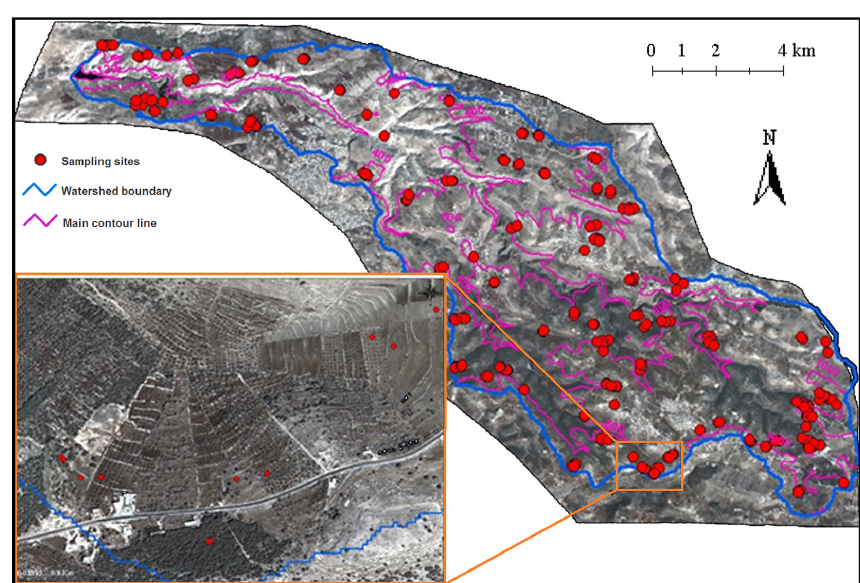
Figure 2. Distribution of sampling sites within the Wadi Ziqlab